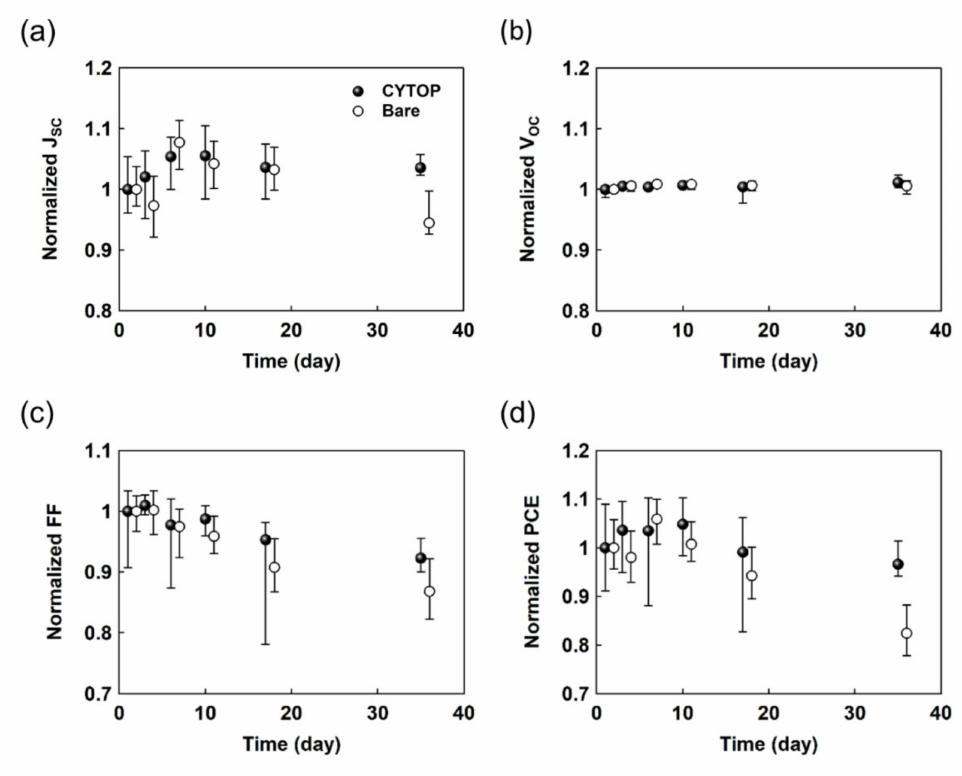
Figure 3. Normalized ( a ) short-circuit current (J SC ), ( b ) open-circuit voltage (V OC ), ( c ) fill factor (FF), and ( d ) power conversion efficiency (PCE) of CYTOP-encapsulated and bare OSCs as a function of aging time.